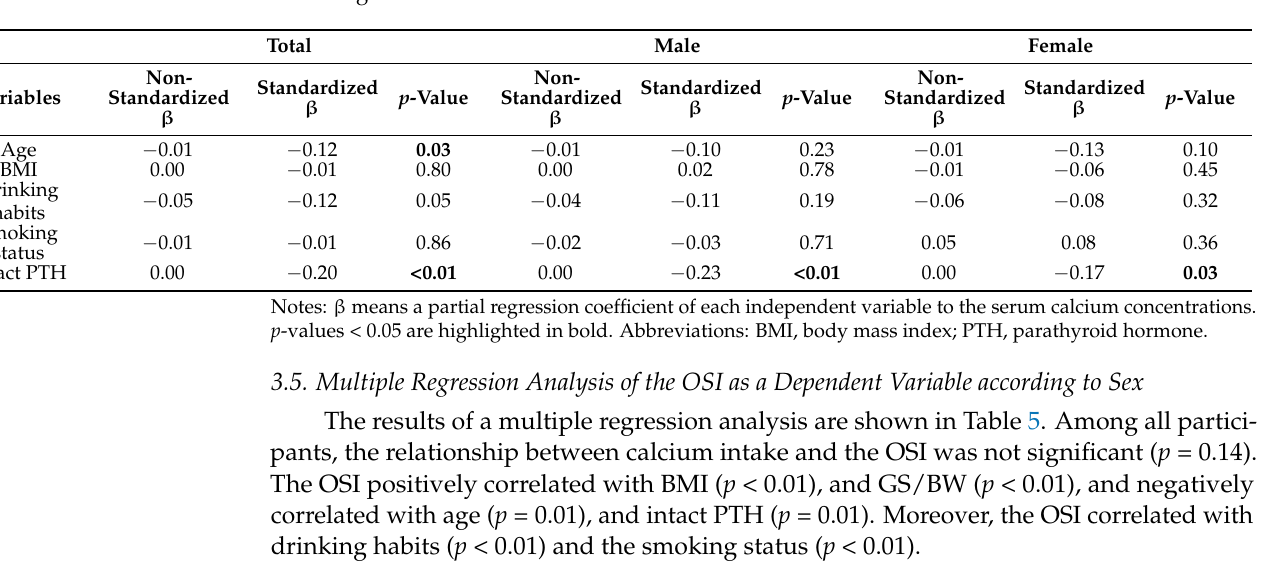
Table 4. Multiple regression analysis of the serum calcium concentrations as a dependent variable according to sex.